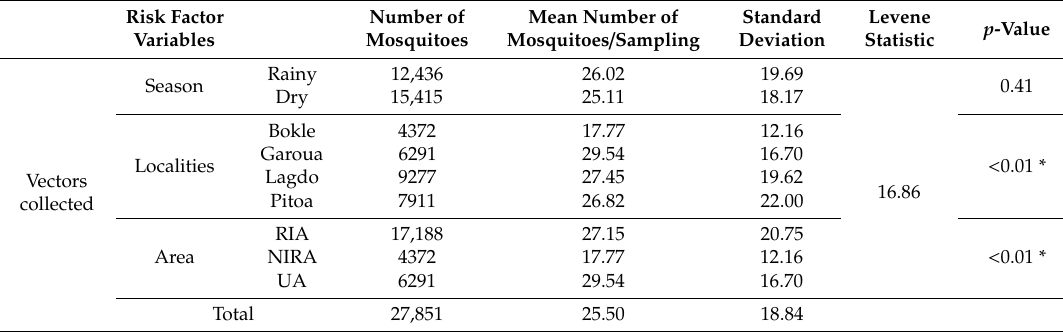
Table 2. Distribution of mosquitoes collected according to risk